Question: Write a single sentence explaining what this figure depicts.
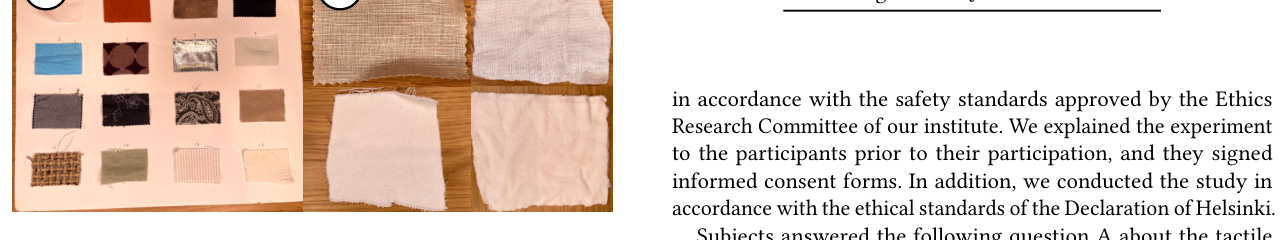
Answer: Experimental procedure. (a) Subjects answered ques- tions about the tactile sensation of the conductive cloth. (b) Subjects selected the most similar tactile sensation cloth among the 16 prepared fabrics. (c) Subjects answered a 5- point Likert scale for roughness, thickness, stiffness, and warmth based on four fabrics: jeans, voile, gauze, and towels.